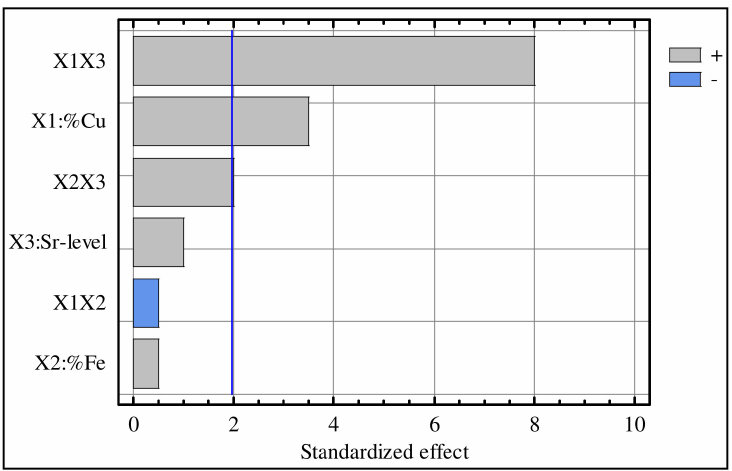
Figure 1. Pareto charts of the standardized effects for hardness